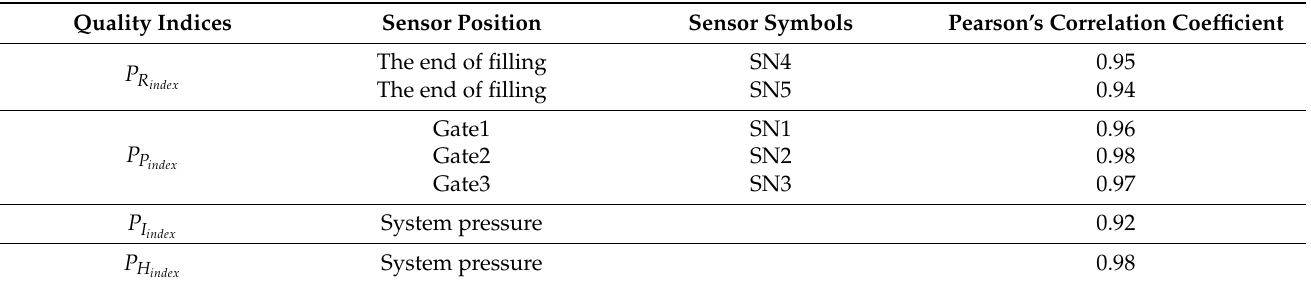
Table 5. Pearson’s correlation coefficients (PCCs) between warpage and quality indices.